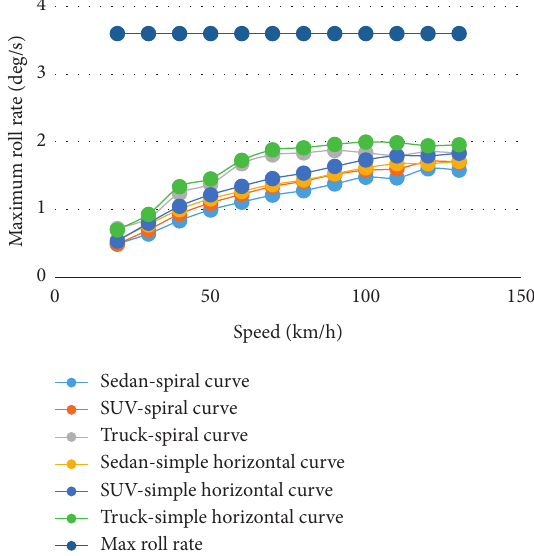
Figure 15: Maximum roll rate versus the speed at radius R in the simple and horizontal curves for various